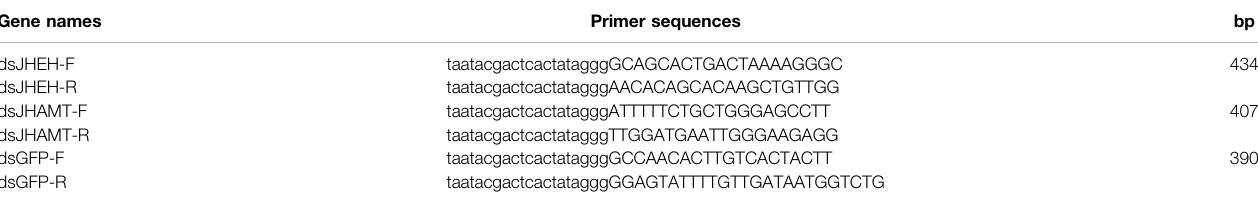
TABLE 1 | Primers for dsRNA